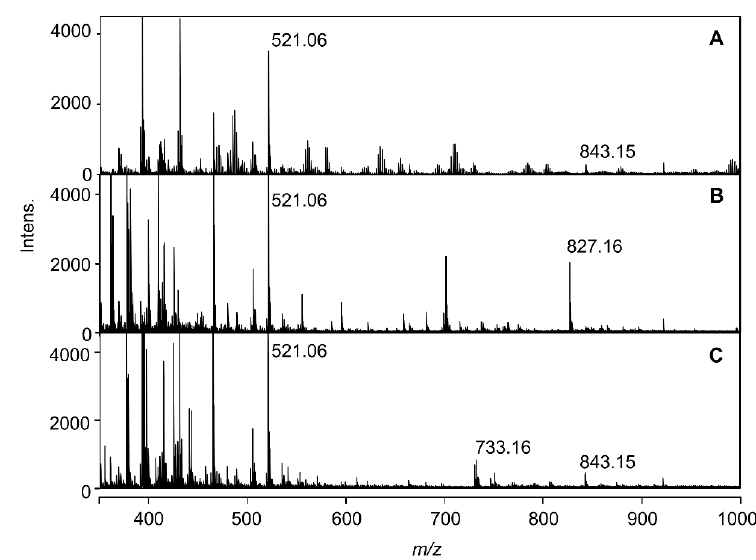
Figure 4. Positive detection ESI-TOF-Mass spectra of reproduced solutions formed by mixing 1 (Dp3G, 0.1 mM) and Al 3+ (1 eq.) with 2 eq. of co-pigment, 5CQ ( 2 ), 5 p CQ ( 3 ), or 3CQ ( 4 ) in buffered solutions at pH 3.2 (2 mM). ( A ) 5CQ ( 2 ). ( B ) 5 p CQ ( 3 ). ( C ) 3CQ ( 4 ).